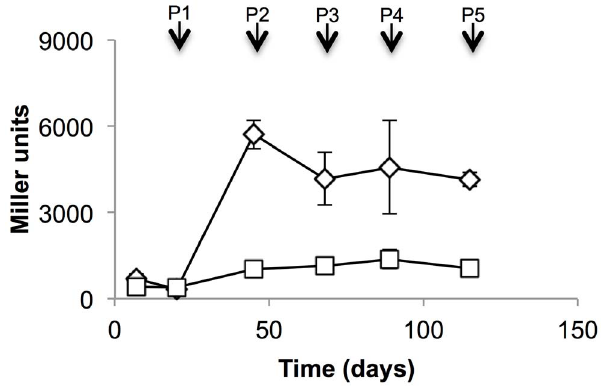
Figure 3. P mbtB and P mbtI are strongly induced in response to iron starvation in M.tuberculosis . (A) mbtB and (B) mbtI promoter activity was measured using a LacZ reporter in bacteria passaged in iron-depleted medium. b -galactosidase activity was measured in cell- free extracts. Diamond – mbtB ; square – mbtI ; P –passage number. Data are the mean and standard deviation from three independent transformations.